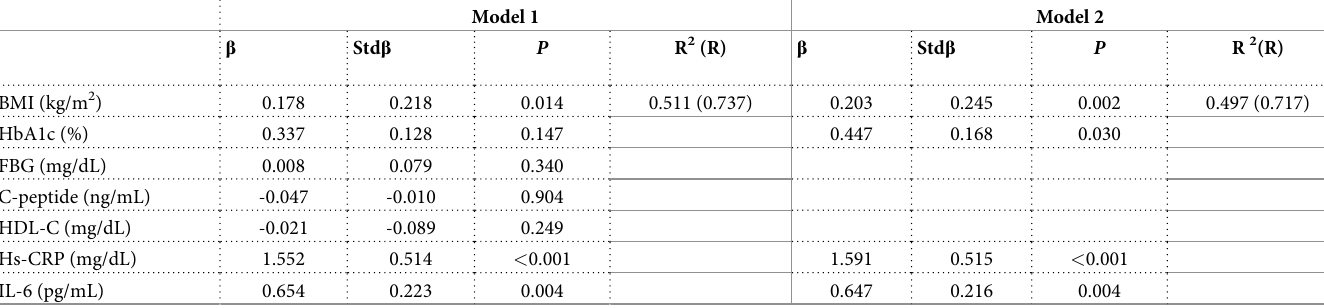
Table 3. Multiple regression analysis of plasma LBP with the stepwise method.